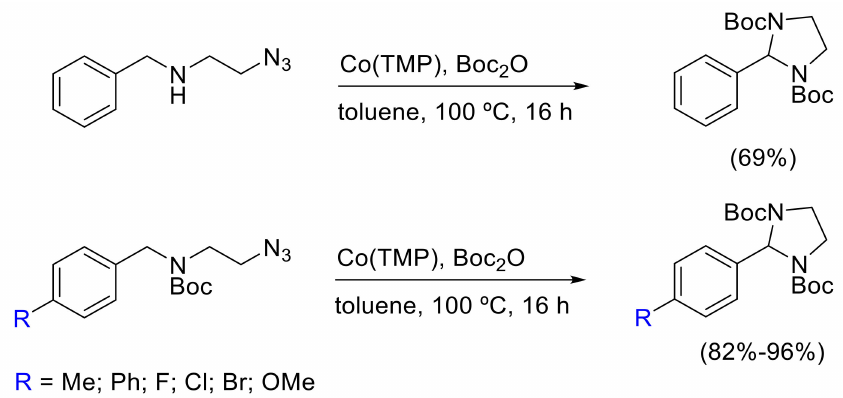
Scheme 60. Catalytic formation of